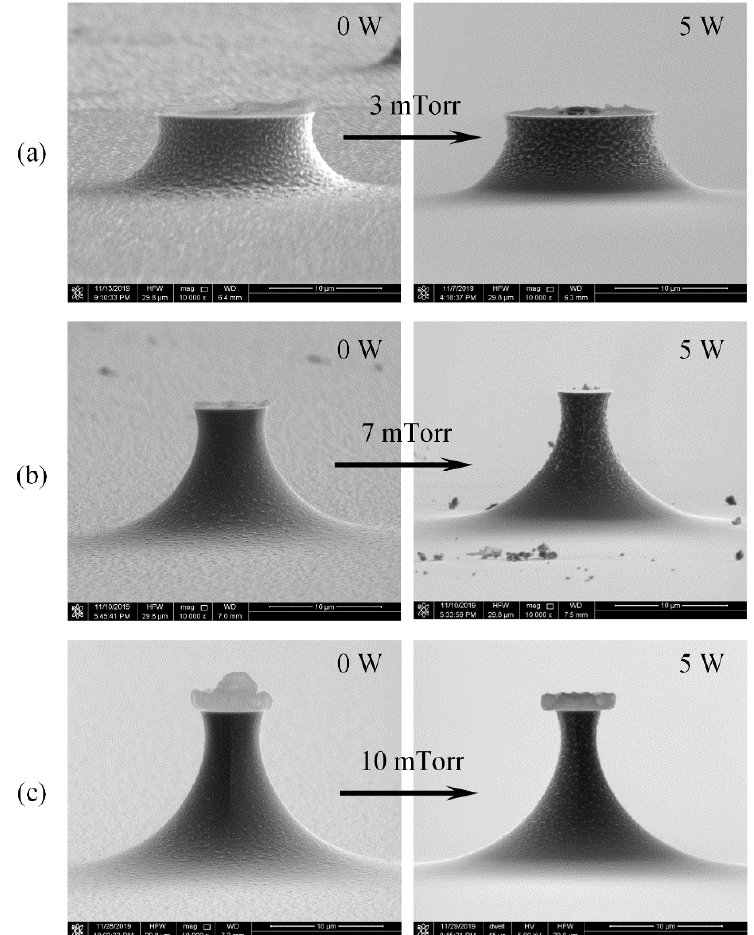
Figure 6. Tip profile fabricated with different platen power with 20 sccm flow rate and 1000 W ICP